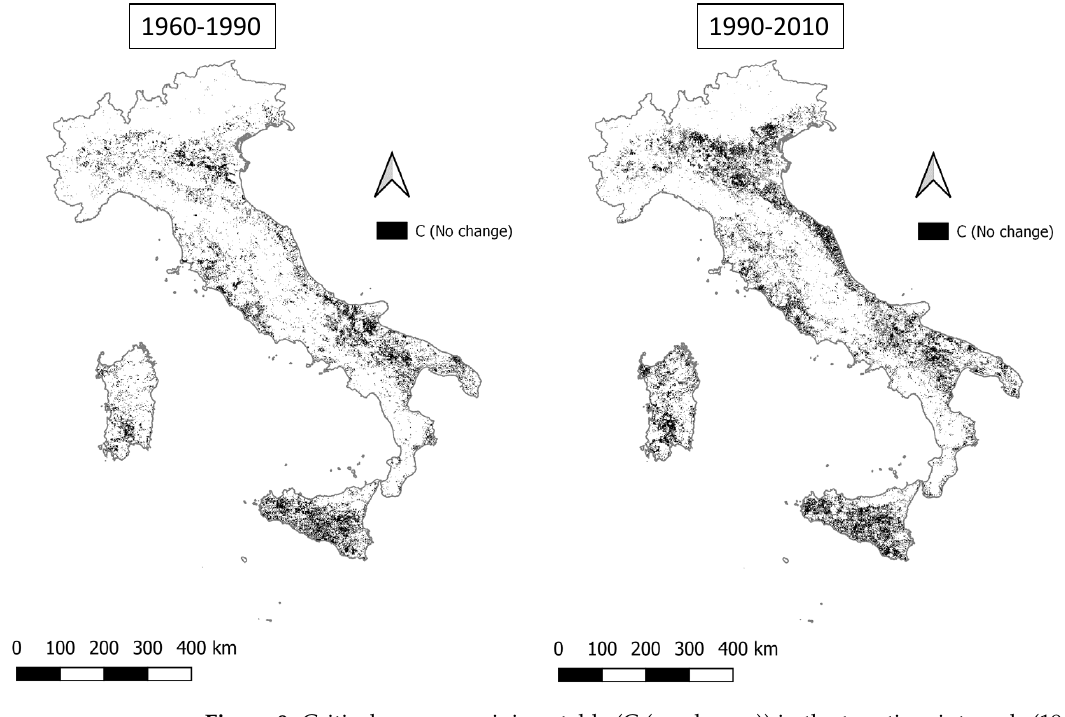
Figure 9. Critical areas remaining stable (C (no change)) in the two time intervals (1960–1990 and 1990–2010).